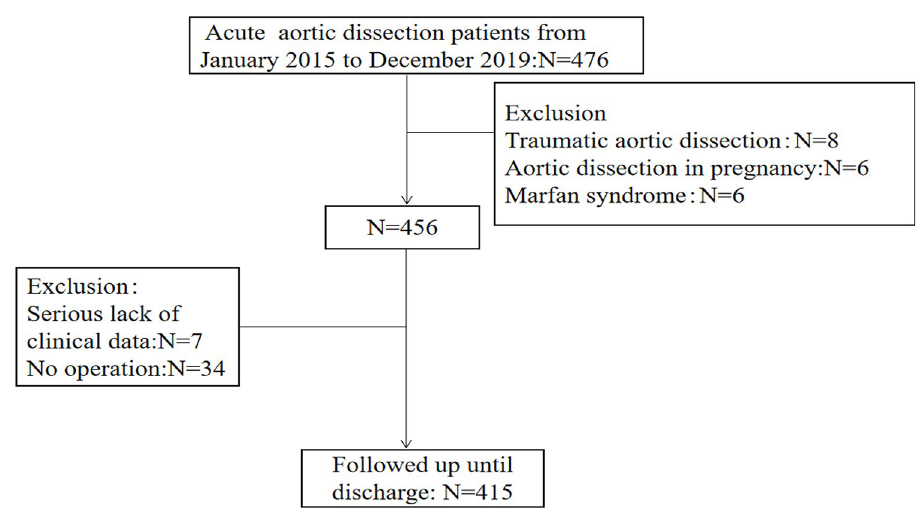
Fig 1. Flow chart of patient